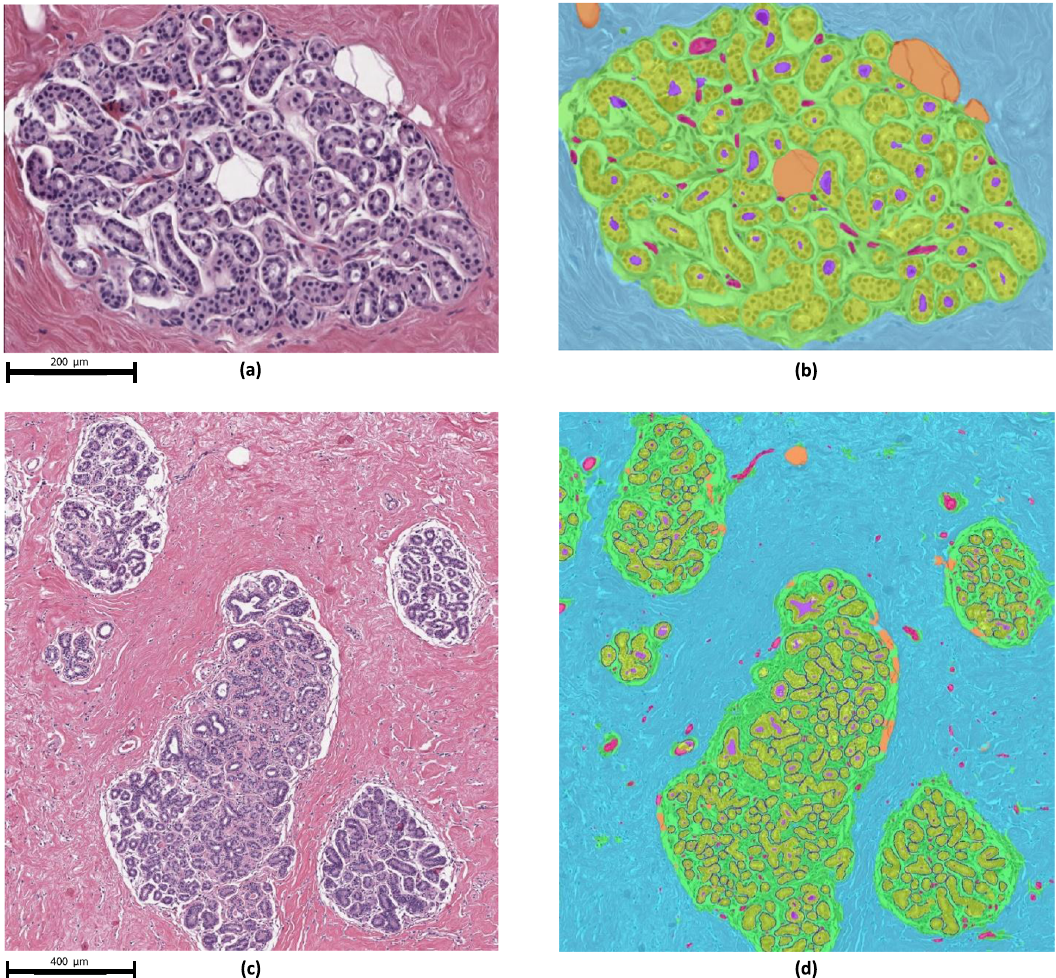
Fig. 1 Structure segmentation visual results: Visual examples of the segmentation results. The top view ( a , b ) shows a single TDLU with epithelium borders removed, with ( a ) and without ( b ) segmentation overlay. The bottom view gives a broad overview ( c , d ). The classes are mapped as follows: epithelium (yellow), intralobular stroma (green), extralobular stroma (blue), lumen (purple), adipose tissue (orange), small vessel (pink), border (dark